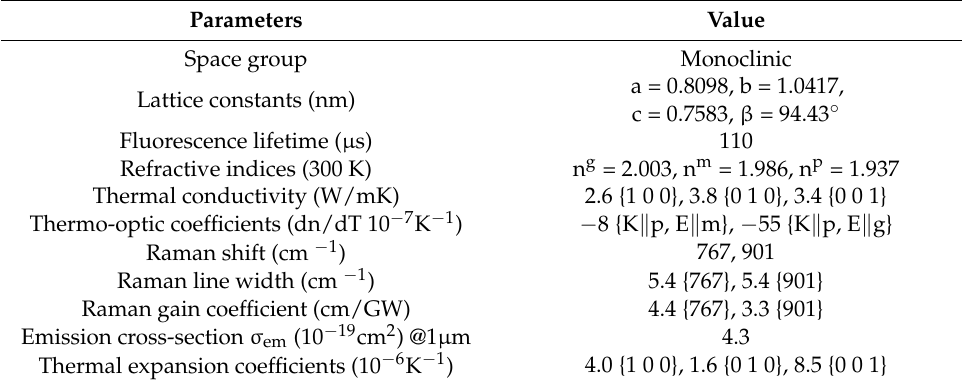
Table 6. Property parameters of the Nd:KGW crystal [26].